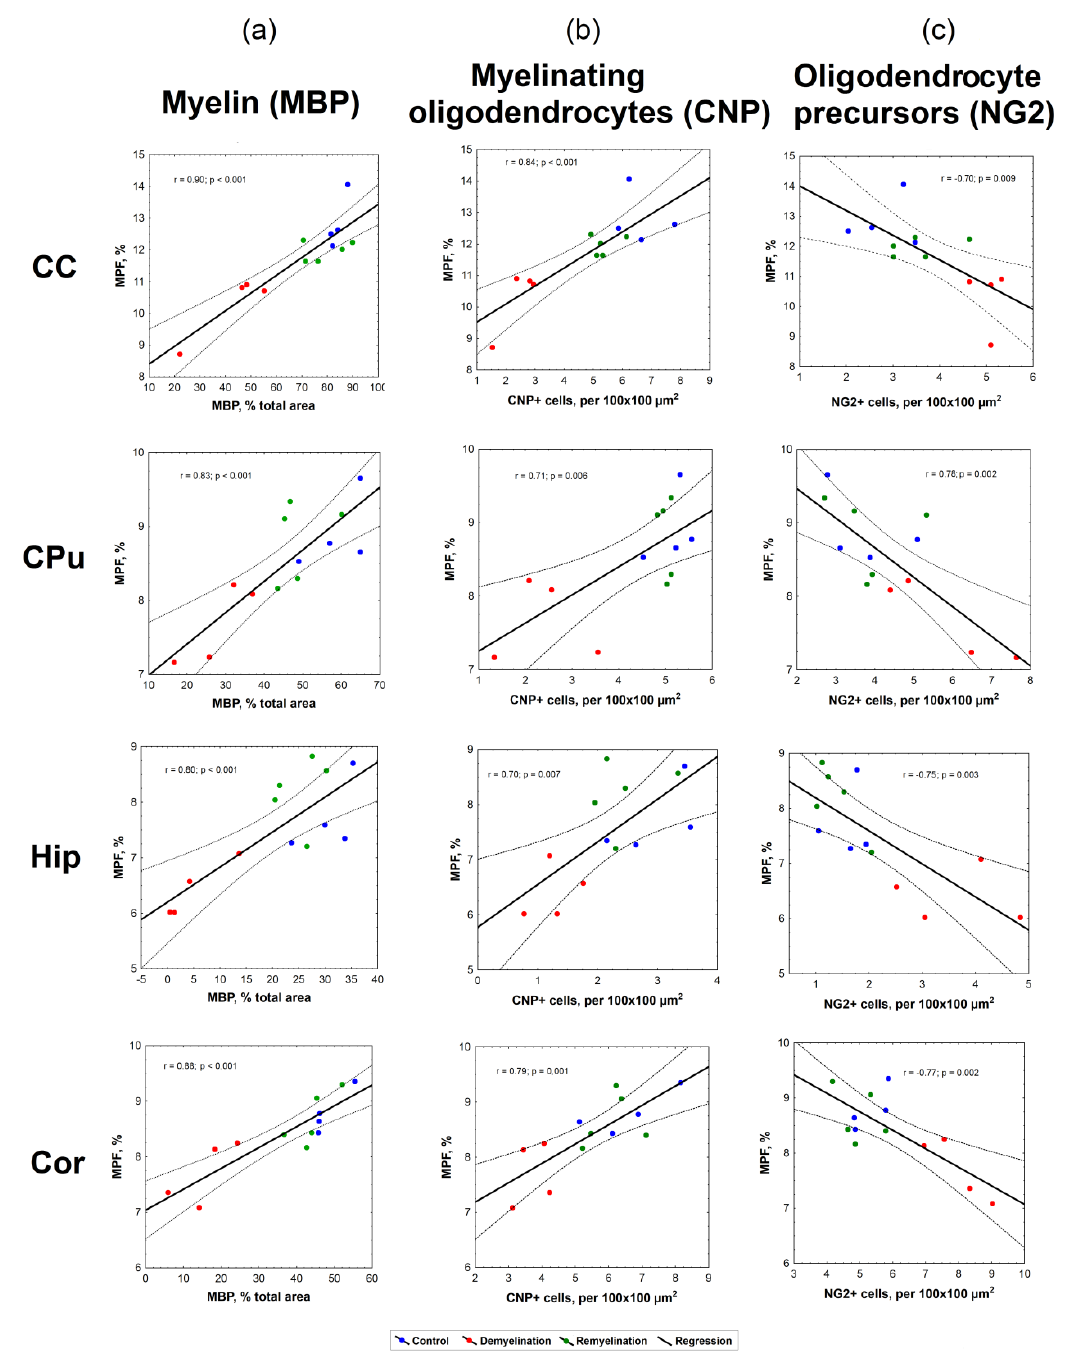
Figure 7. Linear regression analysis of MPF values vs. myelin content according to MBP staining ( a ), the number of myelinating oligodendrocytes according to CNP staining ( b ), and the number of OPC according to NG2 staining ( c ) in the corpus callosum, caudate putamen, hippocampus, and cortex. Blue, red and green dots correspond to the control, demyelination, and remyelination groups, respectively. Black lines depict the plots of the regression equations for the pooled datasets including all groups. Dotted lines represent confidence intervals of the regression lines.